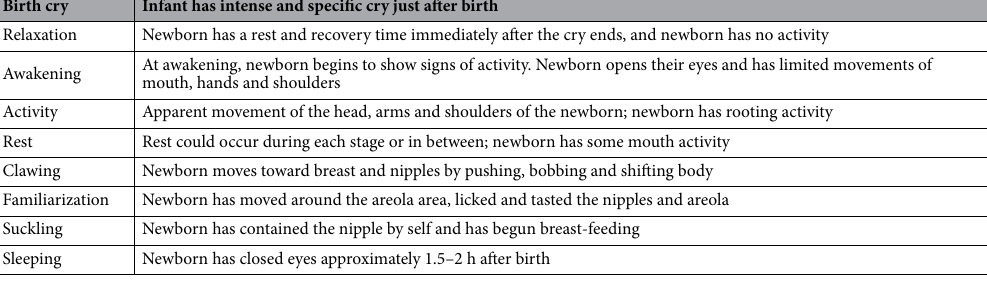
Table 1. Widström’s 9